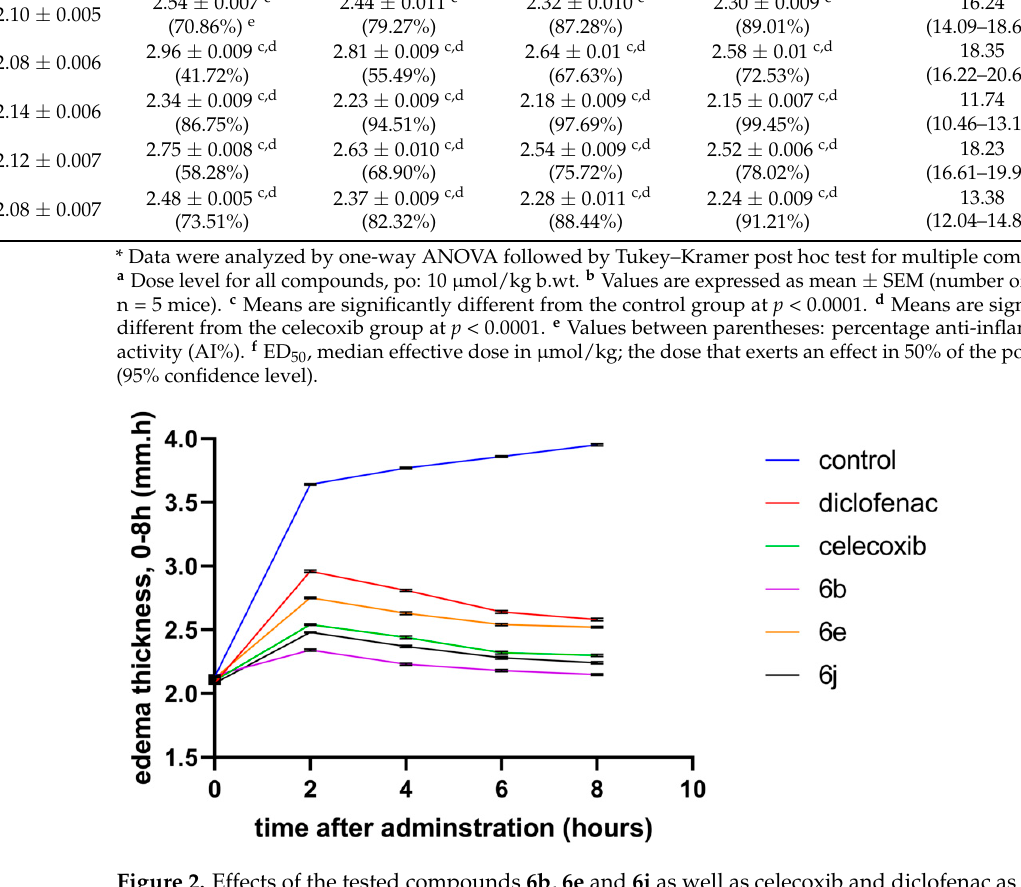
Table 3. Rat serum prostaglandin E2 of the targeted compounds (pg/mL) * and % inhibition of PGE2.